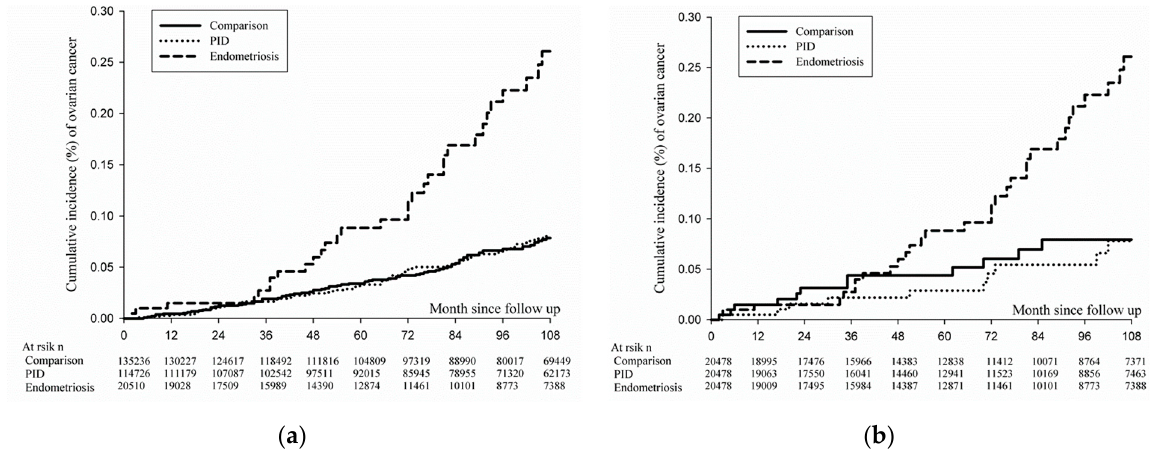
Figure 1. Kaplan-Meier curves for ovarian cancer among PID, endometriosis and control cohorts. (a) before Figure 1. Kaplan–Meier curves for ovarian cancer among PID, endometriosis, and comparison cohorts. ( a ) Before ( p < 0.001) (p<0.001) and (b) after (p<0.001) propensity score matching. PID, pelvic inflammatory disease. and ( b ) after ( p < 0.001) propensity score matching. PID, pelvic inflammatory